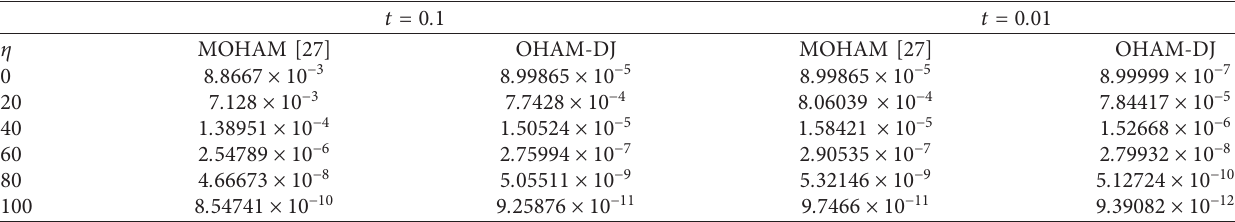
Table 2: Absolute errors obtained by first order OHAM-DJ and comparison is made with MOHAM of ξ ( η ,t ) at t � 1 , ω � 1 . 5 ,l � 0 . 1 ,C � 1 . 5 , and C � 0 . 1. 0 2 t � 0 . 1